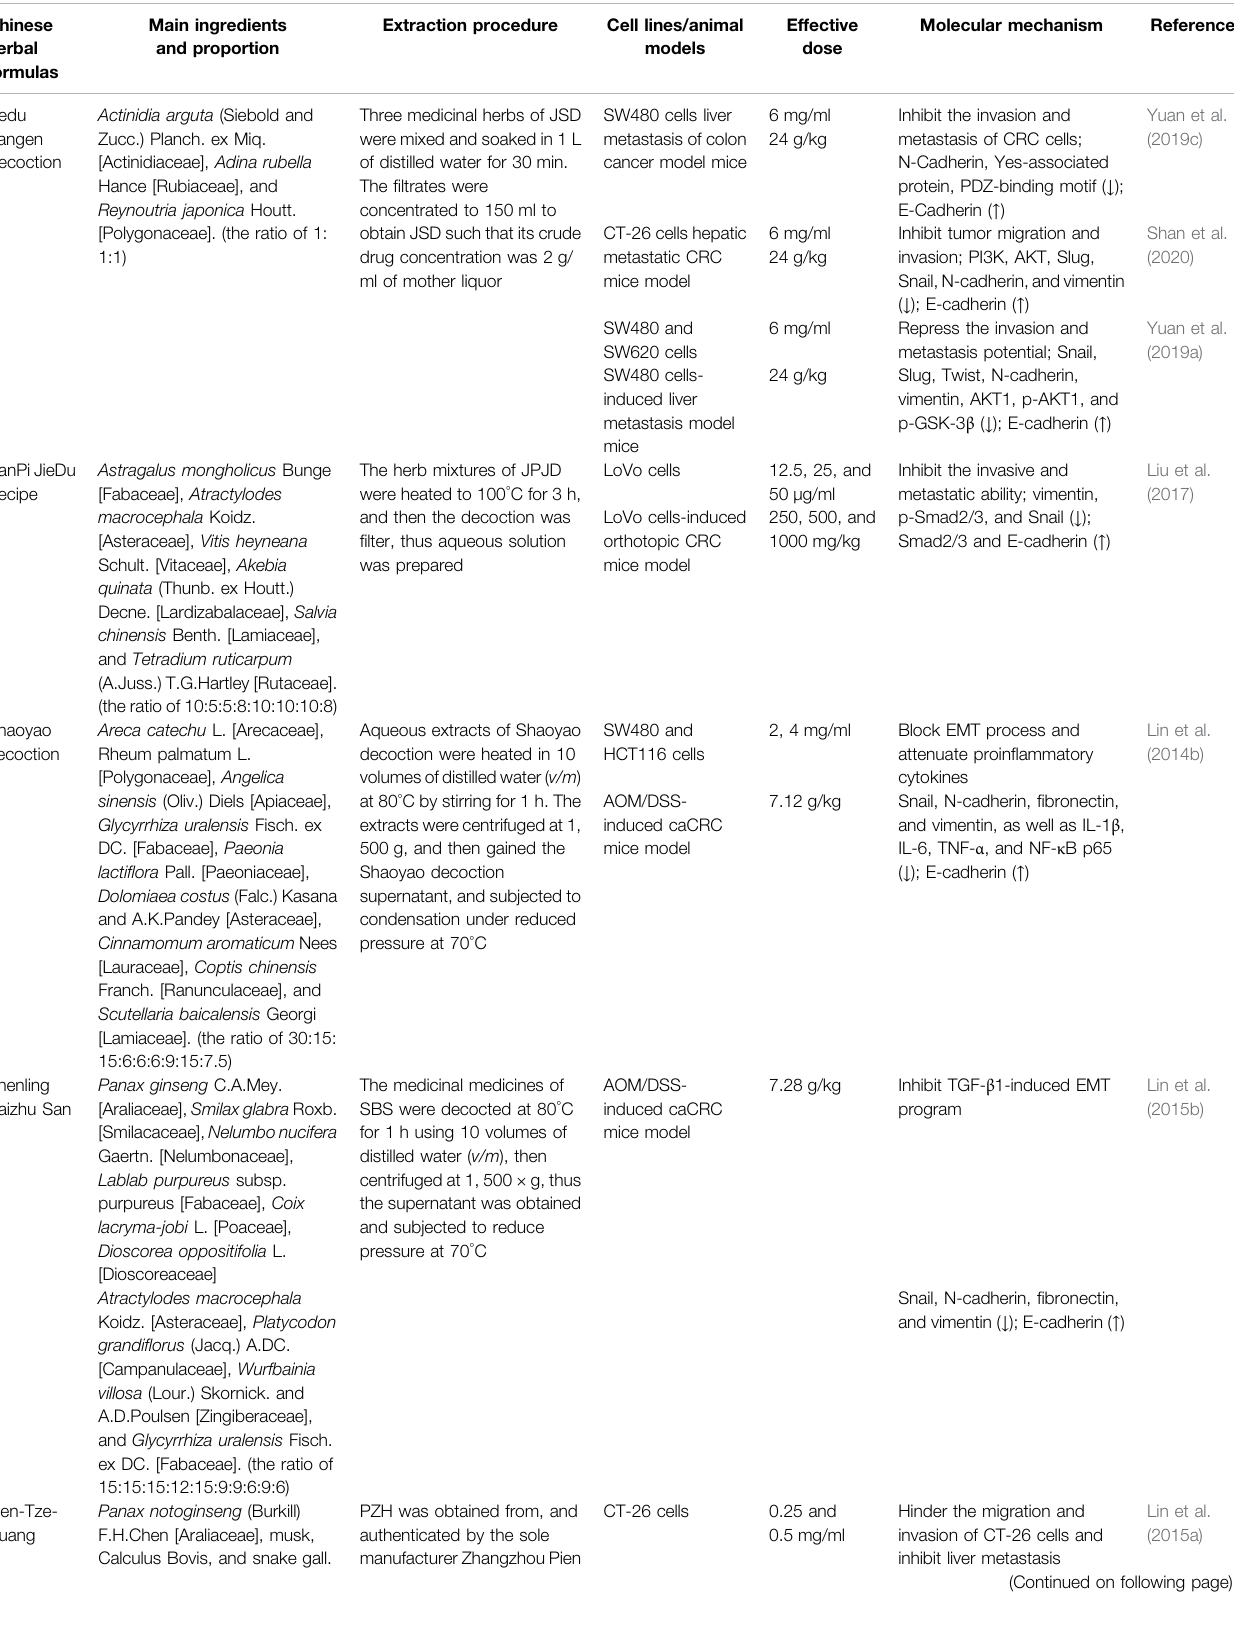
TABLE 3 | Targeting of EMT-related signaling pathways involved in metastatic CRC by Chinese herbal formulas in vitro and in vivo . Chinese herbal